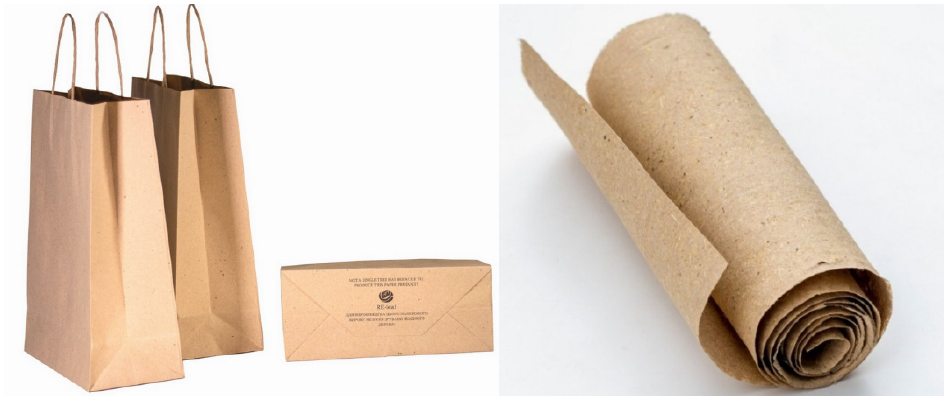
Figure 7. Biodegradable bags made of leaves ( Open source photos ) [8].